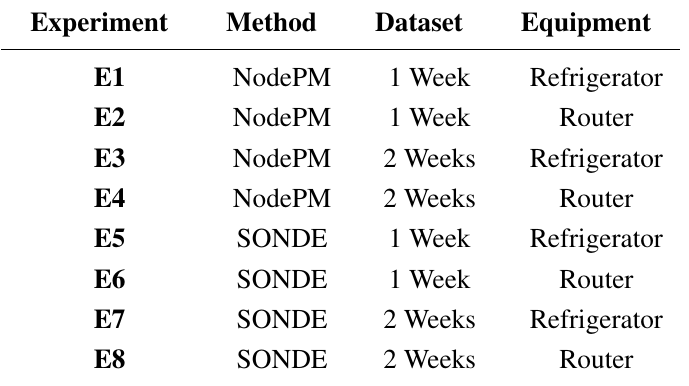
Table 1. Set of parameters chosen to be evaluated. NodePM—Novelty Detection Power Meter method; SONDE—Self-Organizing Novelty Detection